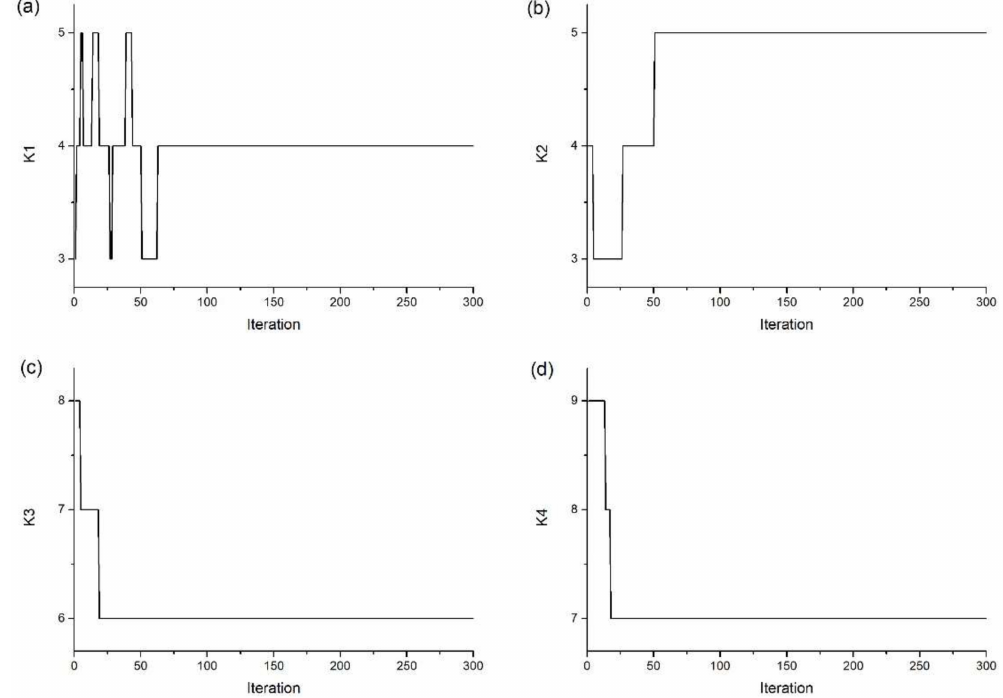
Figure 3. Convergence of the model orders ( a ) K1, ( b ) K2, ( c ) K3, and ( d ) K4 of Cable 1. K1, K2, K3, and K4 are assumed as unknown parameters which are related to the four consecutive frequencies from the simulated